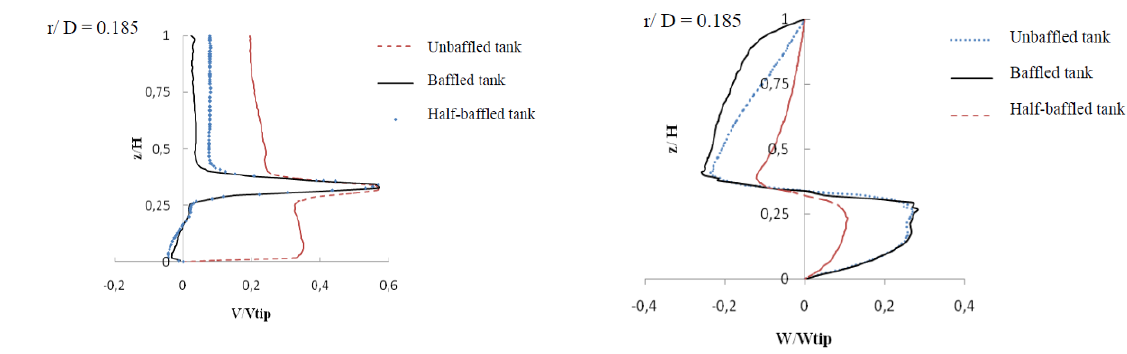
Figure 7. Axial profile of the axial